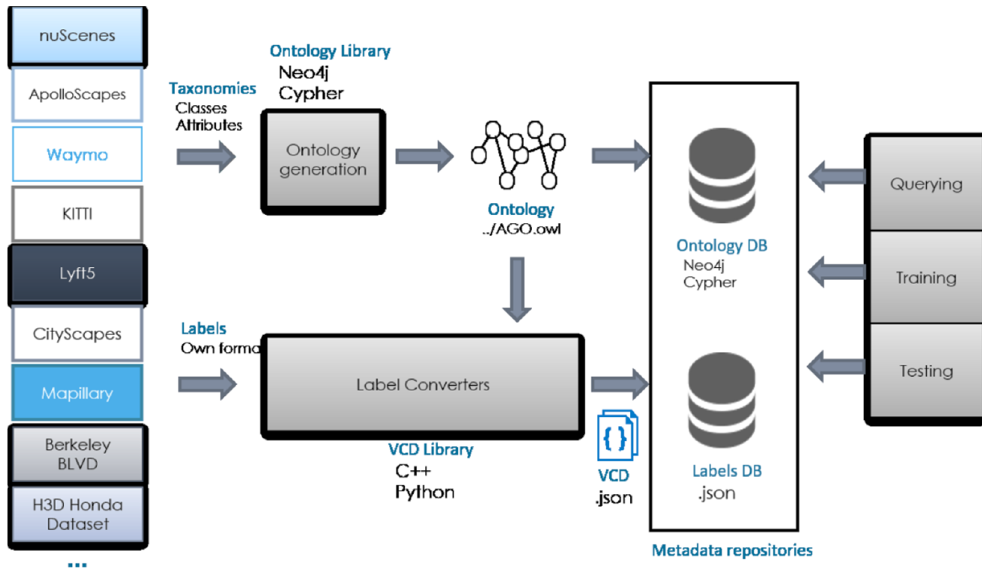
Figure 7. Using AGO ontology for translating of heterogeneous labels (e.g., from different datasets). As an example of the above-mentioned process, Error! Reference source not found. depicts a graphical representation of the classes defined in the “Waymo” dataset mapped to their equivalent AGO classes. The equivalence among elements is defined by the “owl:sameAs” relationship, which means that one can be replaced by the other without altering the meaning and vice versa. This type of application allows identifying the relations among different datasets and translating the terms to the needed terminology. The translation can be performed auto- matically or manually, with user interfaces showing a graph visualization and navigation capabilities. Furthermore, the ontology can be part of a knowledge management system and used before the labels are created, at the annotation or labeling stage (see Error! Reference